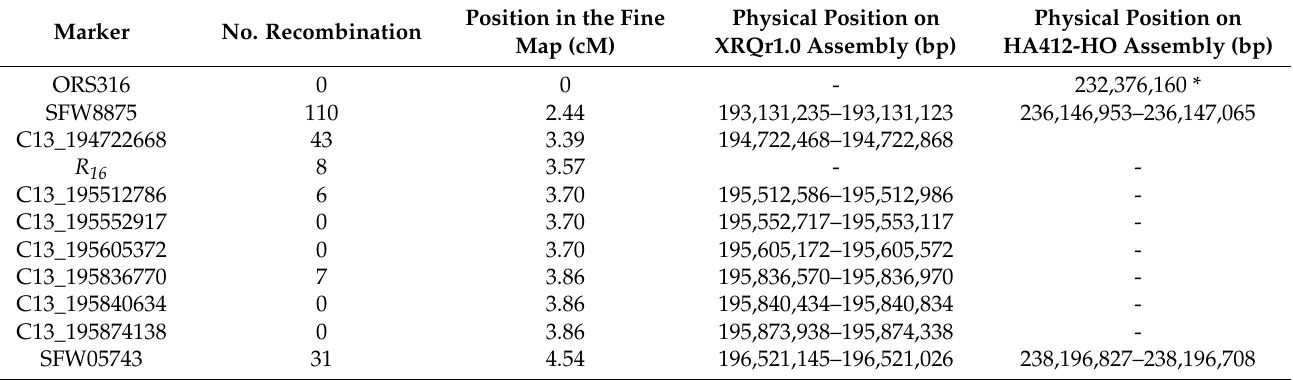
Figure 2. Rust R 16 gene linkage maps. ( a ) Map taken from Liu et al., 2019 [40], ( b ) R 16 saturation map, and ( c ) R 16 fine map. Table 2. Genetic and physical positions of the SNP markers linked to R 16 on a fine map of sunflower chromosome